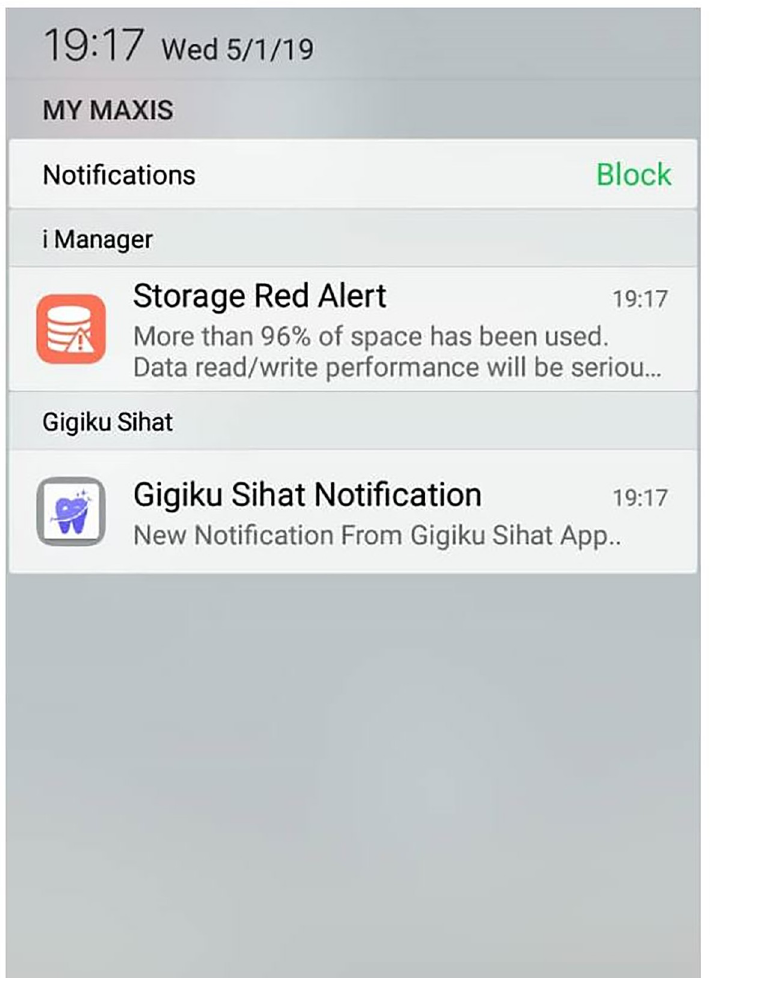
Fig 6. Notification drawer.